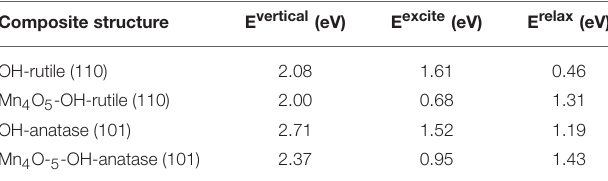
TABLE 2 | Vertical singlet-triplet energy difference (E vertical ), the relaxed singlet-triplet energy difference (E excite ) and the relaxation energy (E relax )